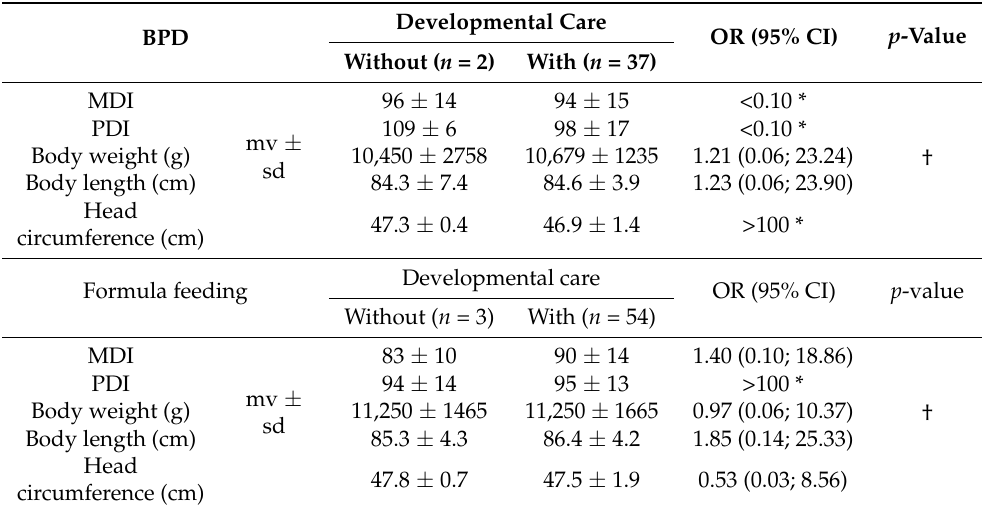
Table 3. Subgroup analysis with BPD children at high risk for developmental deficits, formula at the age of 24 months in BSID-II with and without developmental care at the age of 24 months. Developmental Care OR (95% CI) p -Value BPD Without ( n = 2) With ( n = 37) MDI Body weight (g) 10,450 ± 2758 10,679 ± 1235